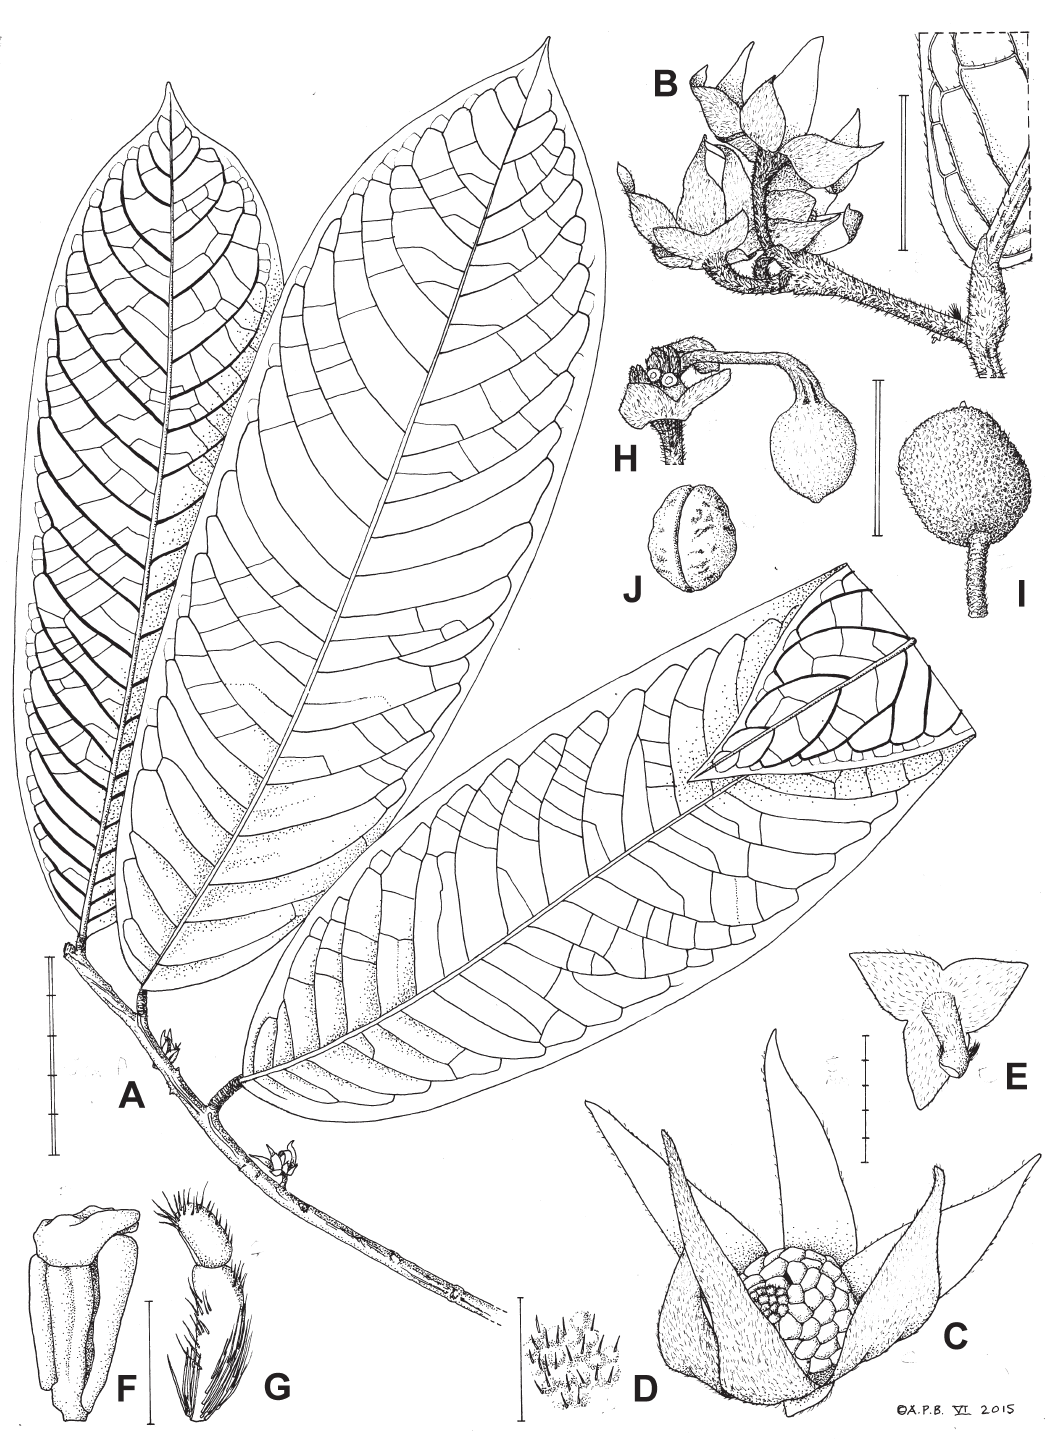
Fig. 1. Polyalthia pakdin I.M.Turner & Utteridge sp. nov. A . Leafy twig with flowers. B . Inflorescence and base of leaf (abaxial view). C . Flower. D . Magnified view of abaxial surface of outer petal. E . Calyx from below. F . Stamen. G . Carpel. H . Infructescense with immature monocarp. I . Mature monocarp. J . Seed. Scale bars: single bar = 1 mm, graduated single bar = 5 mm; double bar = 1 cm, graduated double bar = 5 cm. Drawn from Carrick s.n . (A, C–E), KL 3033 (B, F, G), SFN 40941 (H), FRI 11853 (I), FRI 13467